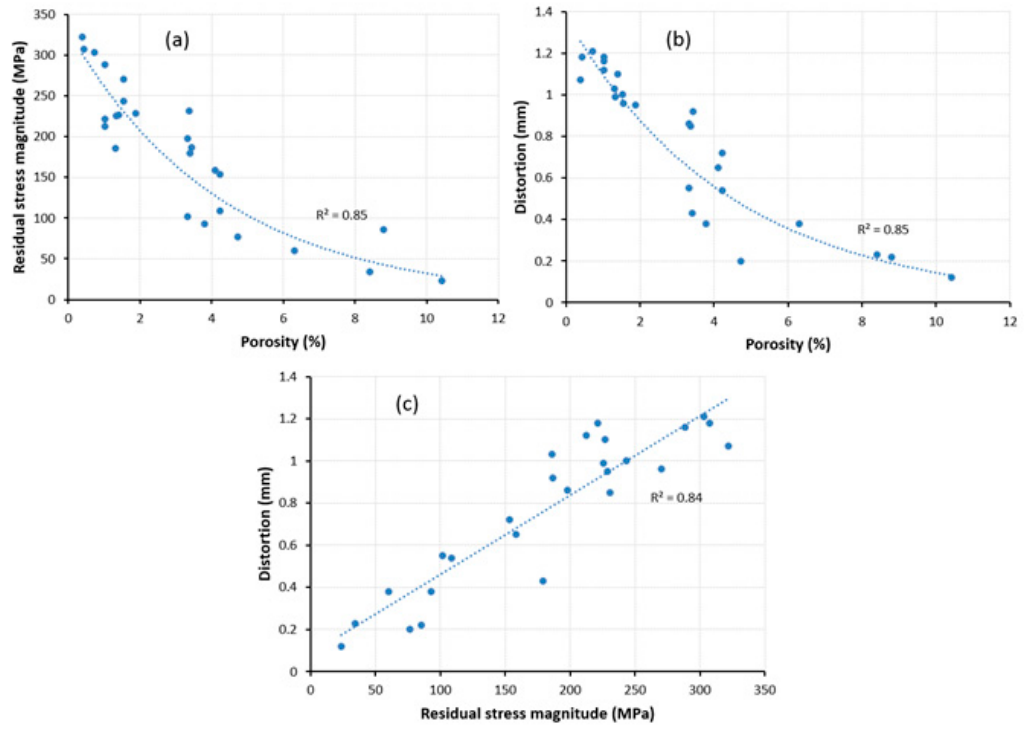
Figure 11. SLM interdependencies: ( a ) porosity–residual stresses, ( b ) porosity–distortions, and ( c ) residual stresses–distortions at 30 µm.